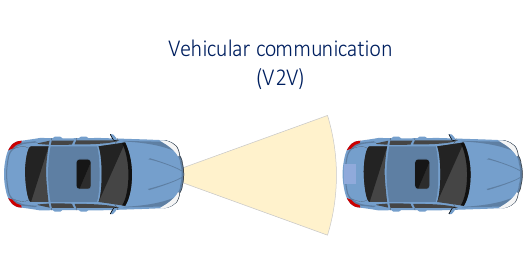
Fig. 1. Illustration of a communication link between two